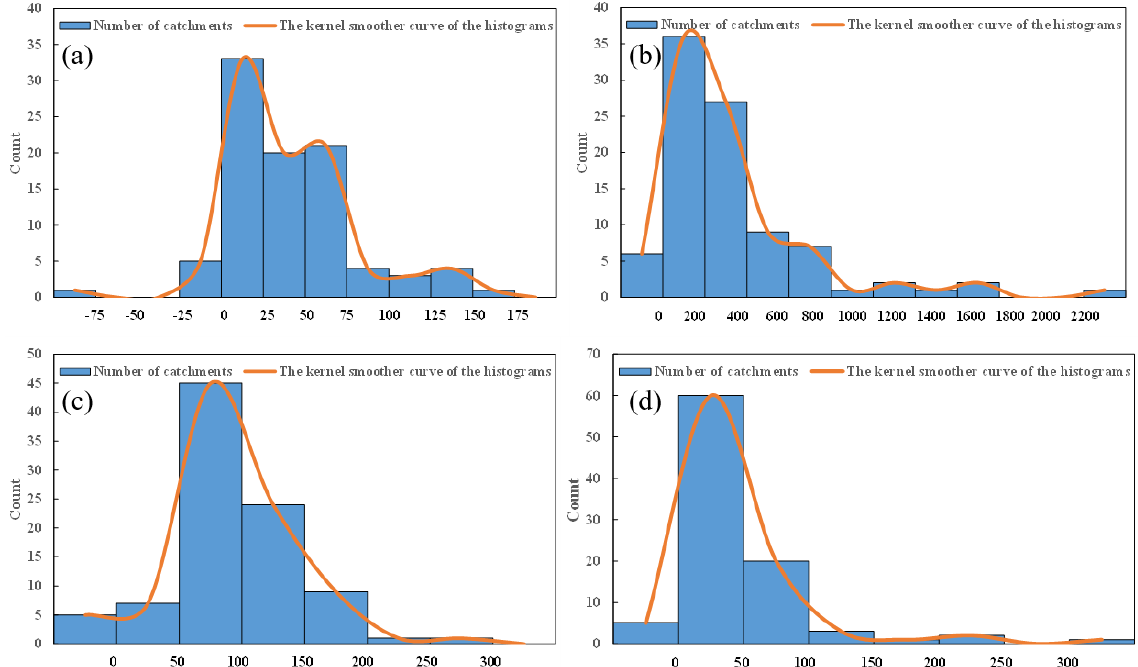
Figure 6. The magnitudes of change in the amplitude and mean value of the ACWSC between the periods before and after the change point. Panels (a) and (b) illustrate the magnitude of absolute and relative percentage changes in estimated parameter α , respectively. Panels (c) and (d) refer to magnitude of absolute and relative percentage changes in the estimated mean value of parameter δ .